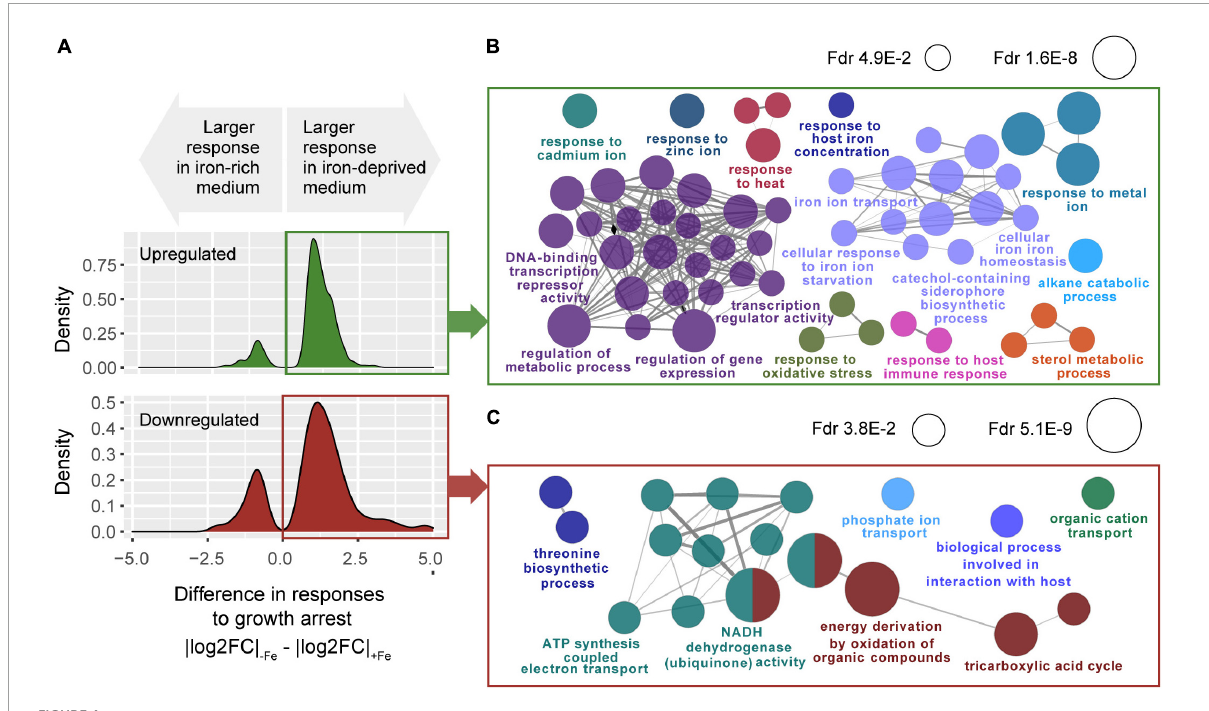
FIGURE4 Transcriptomic response in the interaction of growth arrest with iron deprivation. (A) Distributions of the differences between absolute responses to growth arrest in –Fe versus +Fe cultures, for genes showing significant iron-growth interactions. Top: genes up-regulated upon growth arrest in both iron-rich medium and iron-deprived medium cultures, with a significant growth-iron interaction at FDR < 0.05 [ n = 326, of which 254 (77.9%) were more strongly upregulated in –Fe than +Fe cultures]. Bottom: genes downregulated upon growth arrest in both iron-rich medium and iron-deprived medium cultures, with a significant growth-iron interaction FDR < 0.05 [ n = 202, of which 175 (86.6%) were more downregulated in –Fe than +Fe cultures]. (B) Gene ontology terms enriched among the n = 254 genes more upregulated (EU genes) in –Fe cultures than in +Fe (one-tailed hypergeometric test, FDR < 0.05). (C) Gene ontology terms enriched among the n = 175 genes more downregulated (ED genes) in –Fe cultures than in +Fe (one-tailed hypergeometric test, FDR <